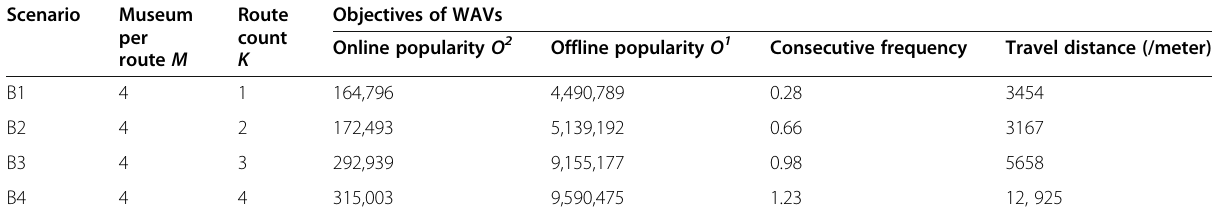
Table 2 Objective of WAV routes with free departure